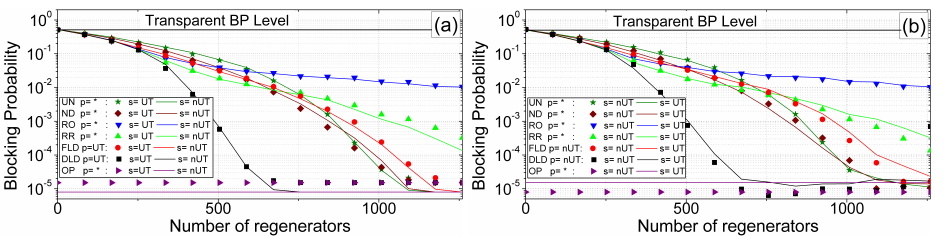
Figure 3. Blocking probability as a function of the total number of regenerators in EuroNet topology under 500 erlangs load: ( a ) uniform and ( b ) non-uniform traffic.